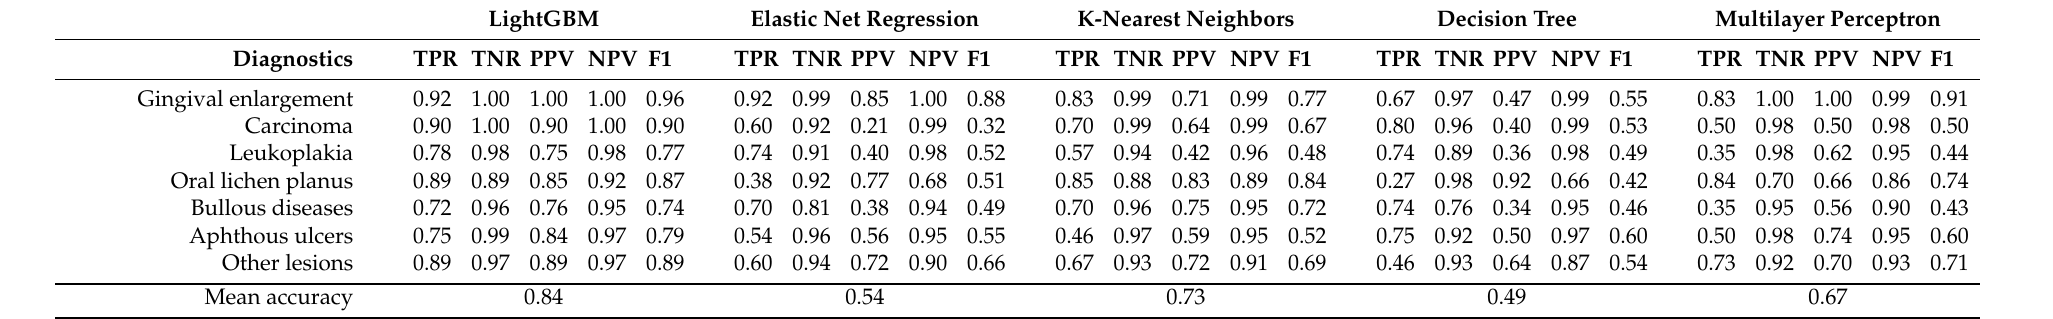
Table 2. Models’ performances for each